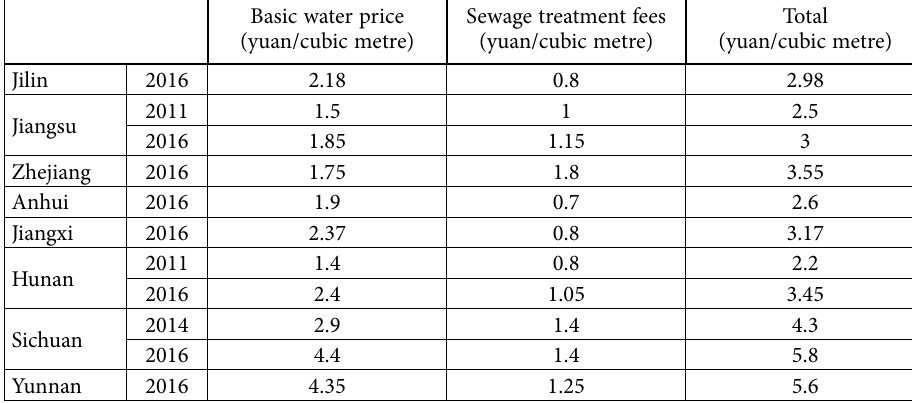
Basic water price (yuan/cubic metre)